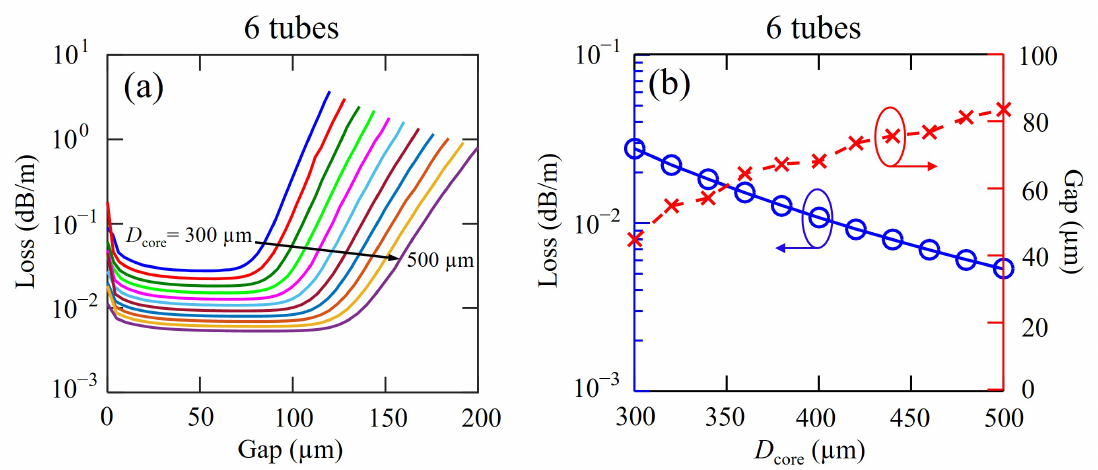
Figure 6. ( a ) Loss as a function of gap in fibers with different core diameters. ( b ) Minimum loss and corresponding optimum gap in fibers with different core diameters. There are six cladding